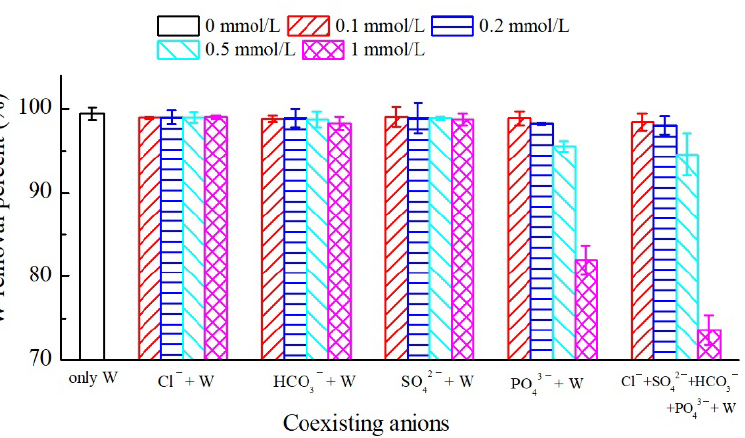
Figure 9. Effects of co-existing anions on tungstate sorption by delaminated iron-based LDH with reaction conditions: initial tungsten concentration = 0.1 mM, solid/solution ratio = 2 g/L, reaction time = 24 h, and T = 25 °C.